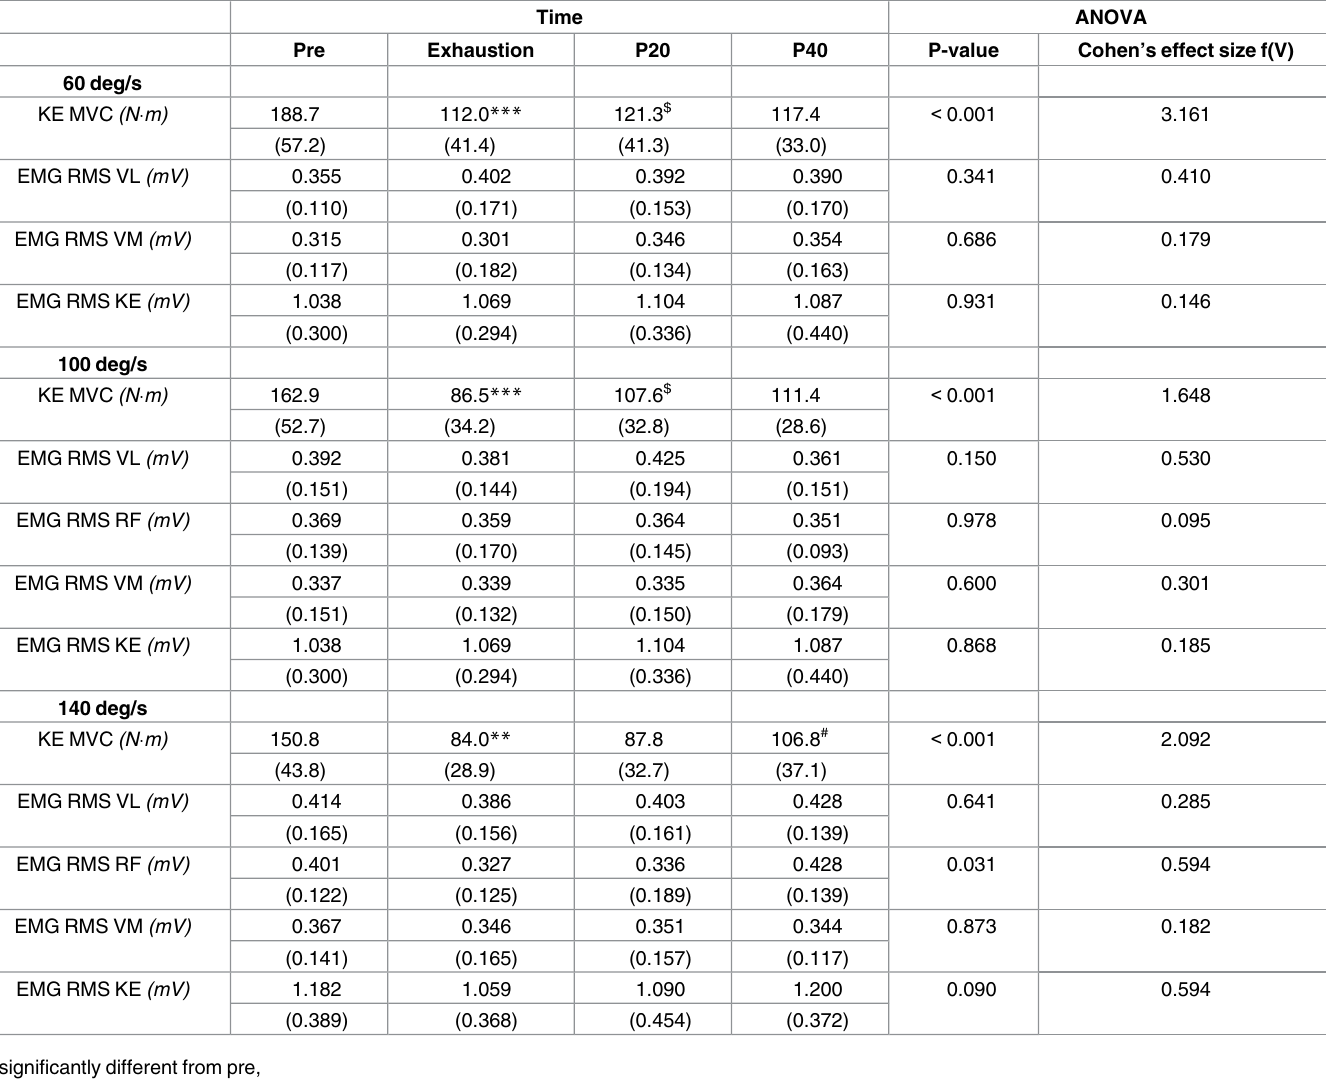
Table 3. Time course of isokinetic knee extensors maximal voluntary contraction (KE MVC) and EMG root mean square (EMG RMS) following the time to exhaustion tests (85% peak power output). KE MVCs were performed at 60, 100 and 140 deg/s. Testing was performed pre-exercise (pre, aver- age of all three sessions pre-exercise values), shortly after exhaustion(13 ± 4 s after exhaustion), 20 s followingexhaustiontest (P20) and 40 s following exhaustion test (P40). As pre-exercise values for the EMG RMS RF at 60 deg/s differ between sessions (P = 0.038), its time course was not analyzed. Plannedcomparisons failed to demonstrate significant differencebetween means for EMG RMS RF at 140 deg/s. VL, Vastus Lateralis muscle; RF, Rectus Femoris muscle; VM, Vastus Medialis muscle, KE, knee extensor muscles (sum VL, RF and VM). Data are presented as mean